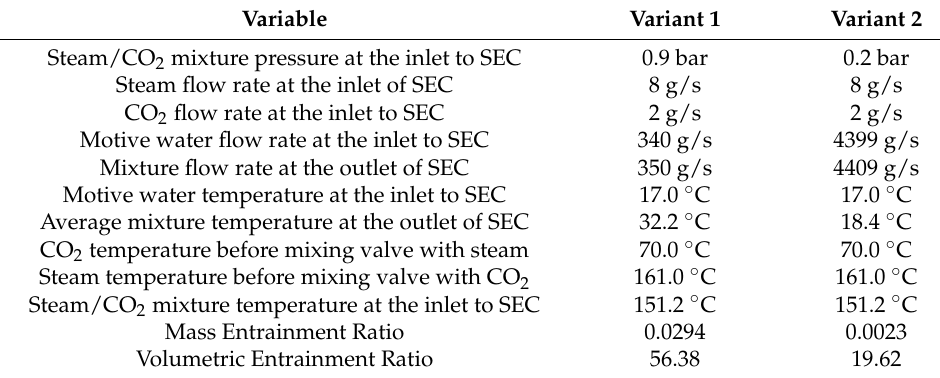
Table 2. Simulated values of operating variables in two variants.